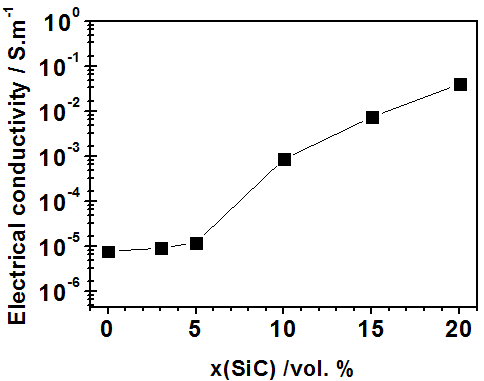
Figure 6. Composition dependence of DC electric conductivity of Al 2 O 3